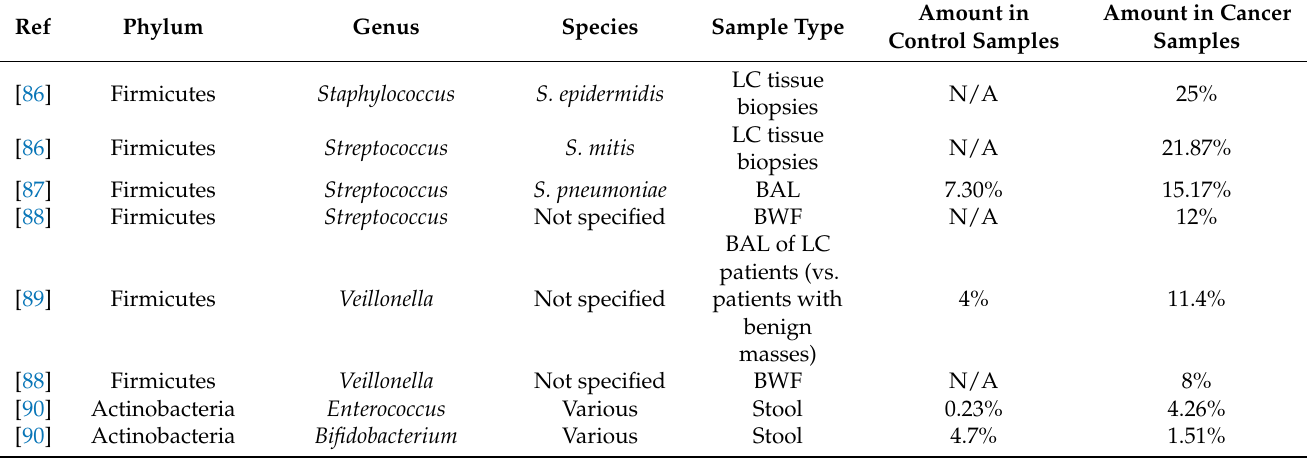
Table 1. Relationship between microbiota and lung